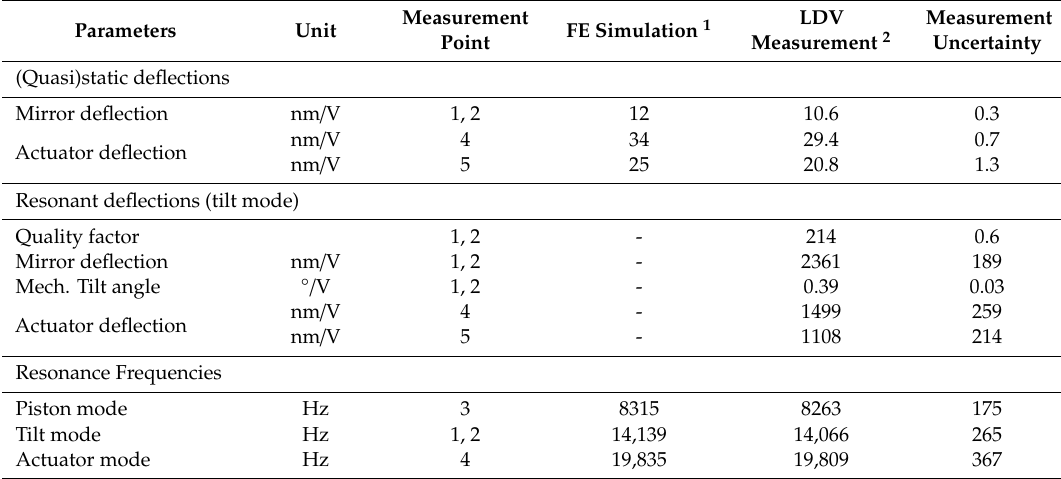
Figure 20. Out-of-plane modes, measured by laser-Doppler-vibrometry for Design 1 and Design 2. Table 4. Comparison of finite elements (FE) simulation and laser-Doppler-vibrometry (LDV) measurement of Design 1.